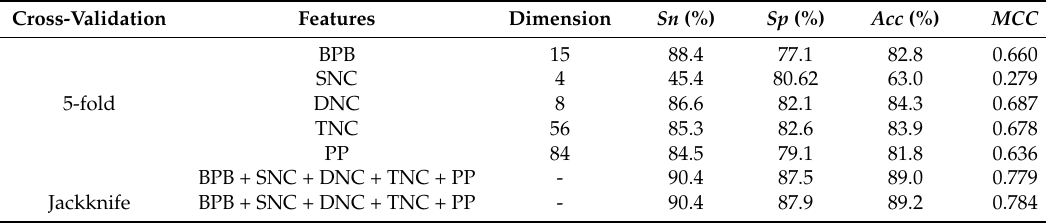
Table 2. The best prediction achieved by single type of features for the first